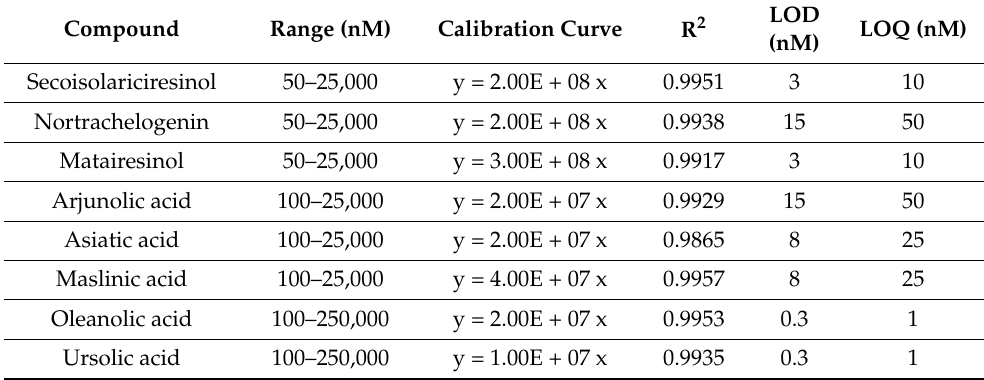
Table 2. Characteristics of the quantitative evaluation of lignanic and triterpenic